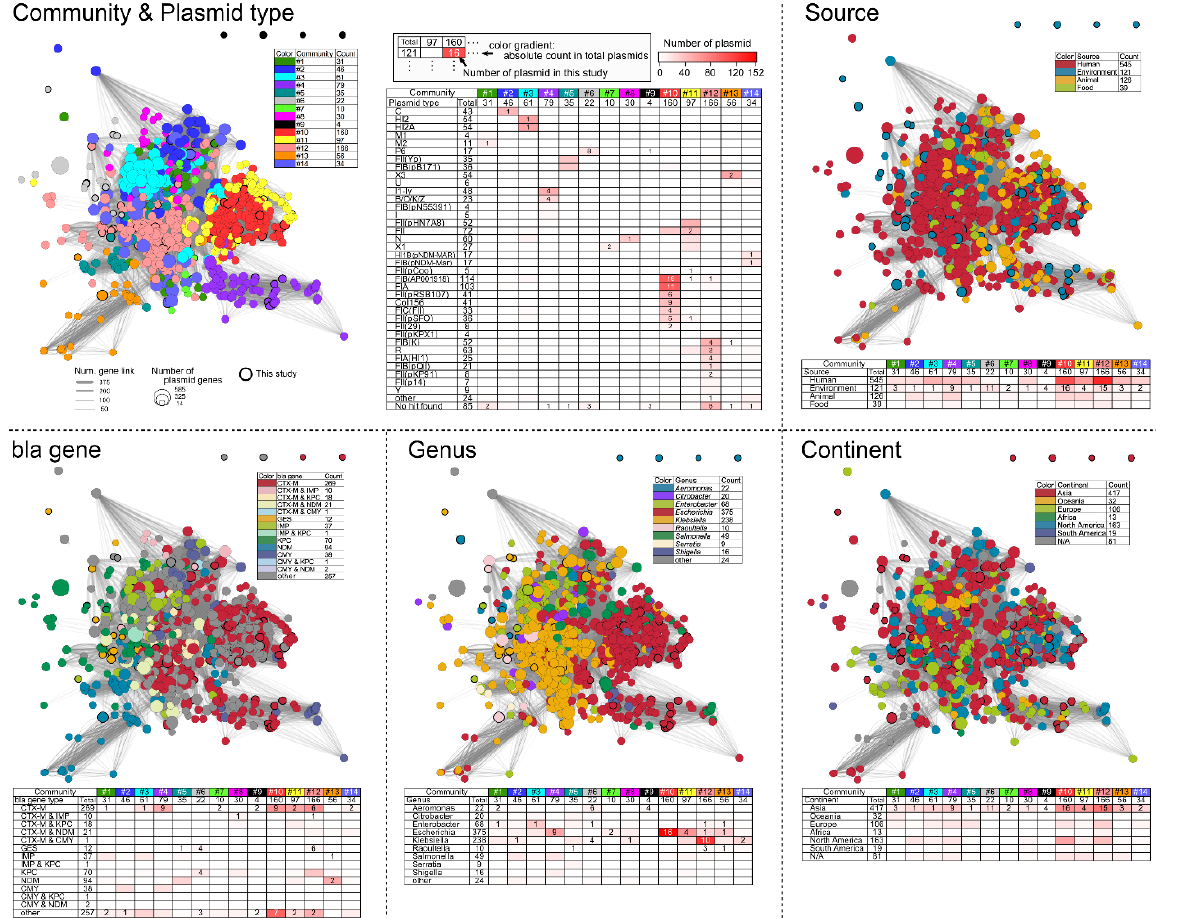
Figure 6. Plasmidome analysis of EPB and CPB isolates from WWTP effluents and environment. Nodes on the network are illustrated with different colors based on communities with sequence similarity, source, bla gene type, host bacteria genus, and its isolate location on the continent. The absolute counts for plasmids in plasmidome analysis are summarized in Table